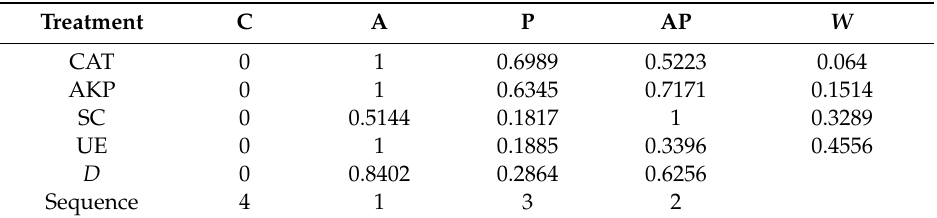
Table 2. Soil fertility assessment in the rhizosphere of Elaeagnus angustifolia L. seedlings under di ff erent treatments using the subordinate function value